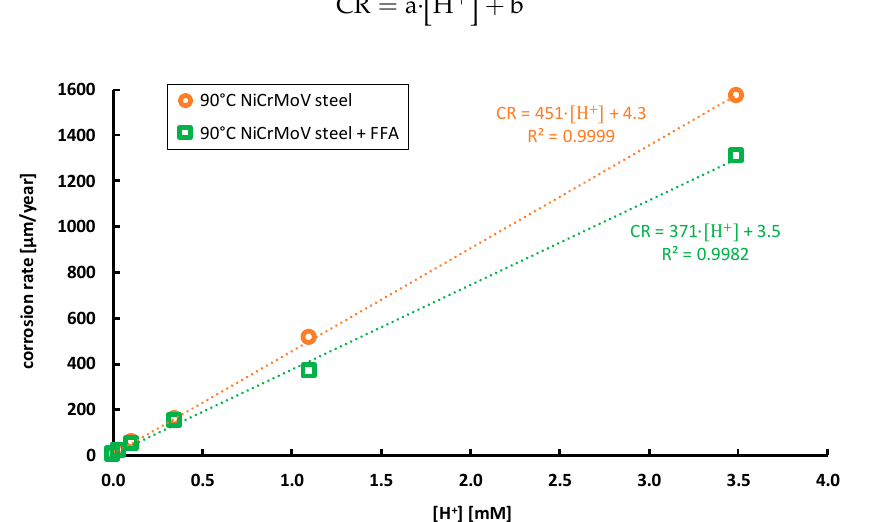
Figure 15. Influence of FFA coating on corrosion rate (µm/year) of NiCrMoV steel at 90 °C for different hydrogen proton concentrations (mM).